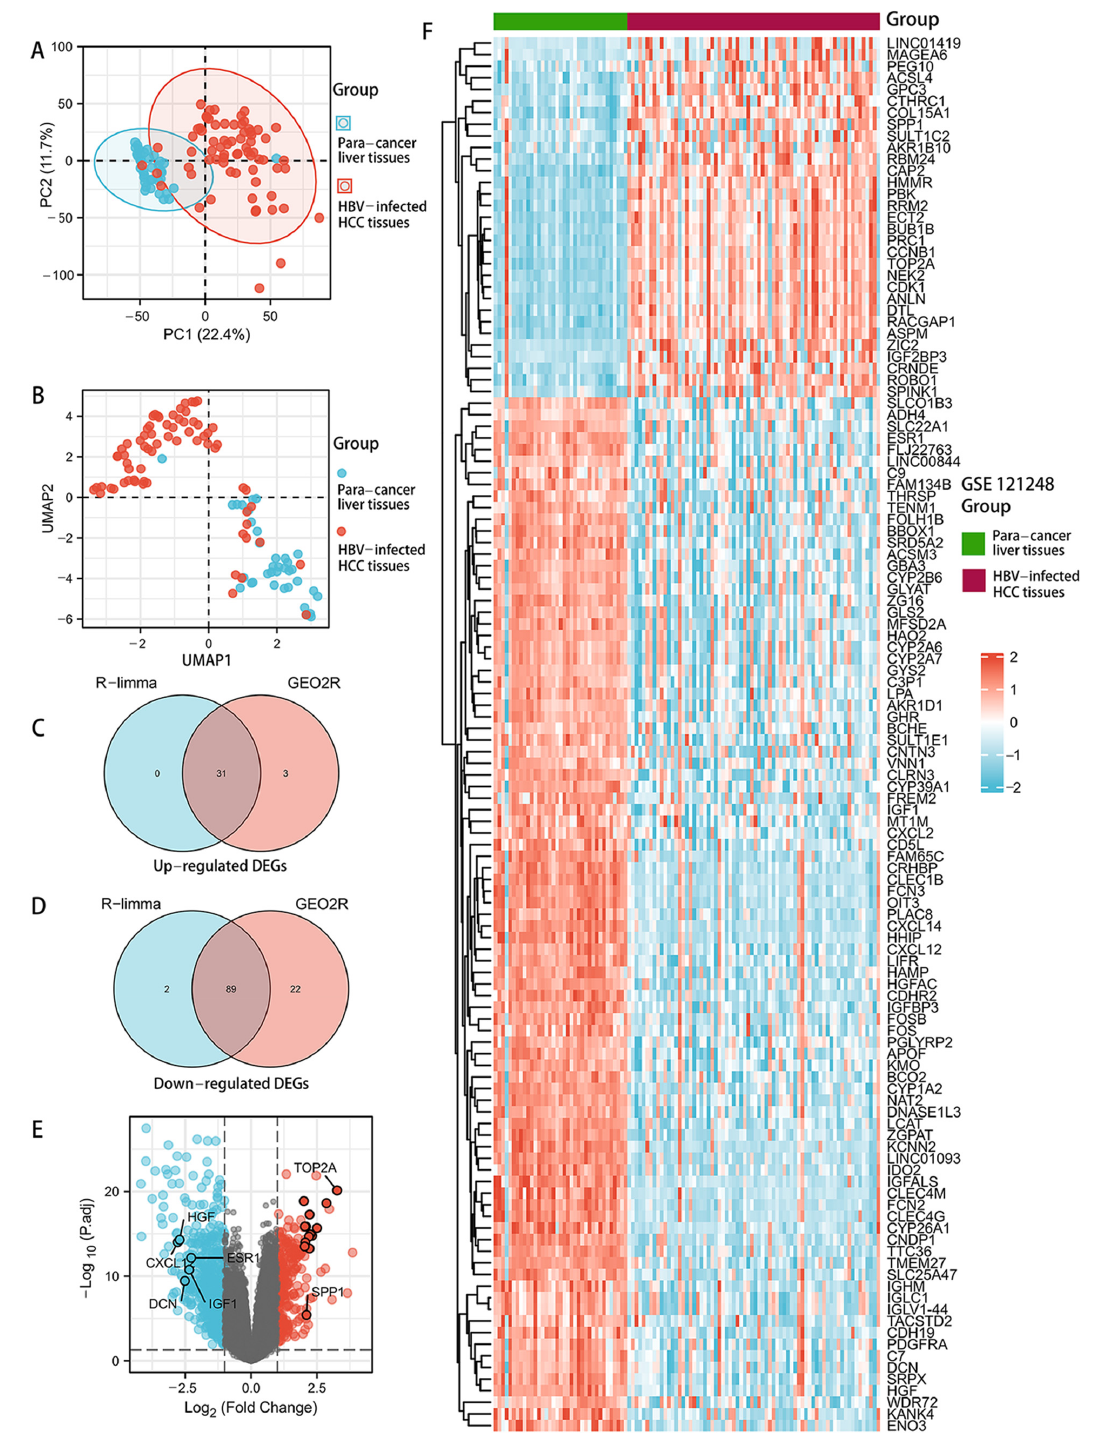
Figure 2. Exploration of potential DEGs in the GSE121248 dataset. The PCA plot ( A ) and UMAP clustering plot ( B ) based on samples from the para-cancer liver tissue group and the HBV-infected HCC tissue group. The distance of sample point clusters indicates that they come from different groups. The Venn diagram of up-regulated DEGs ( C ) and down-regulated DEGs ( D ) between the two methods. Volcano plots of DEGs ( E ). Blue and red indicate down-regulated overlapping DEGs and up-regulated overlapping DEGs, respectively. The expression profiles of overlapping DEGs between HBV-infected HCC tissues and para-cancer liver tissues were visualized in a heatmap ( F